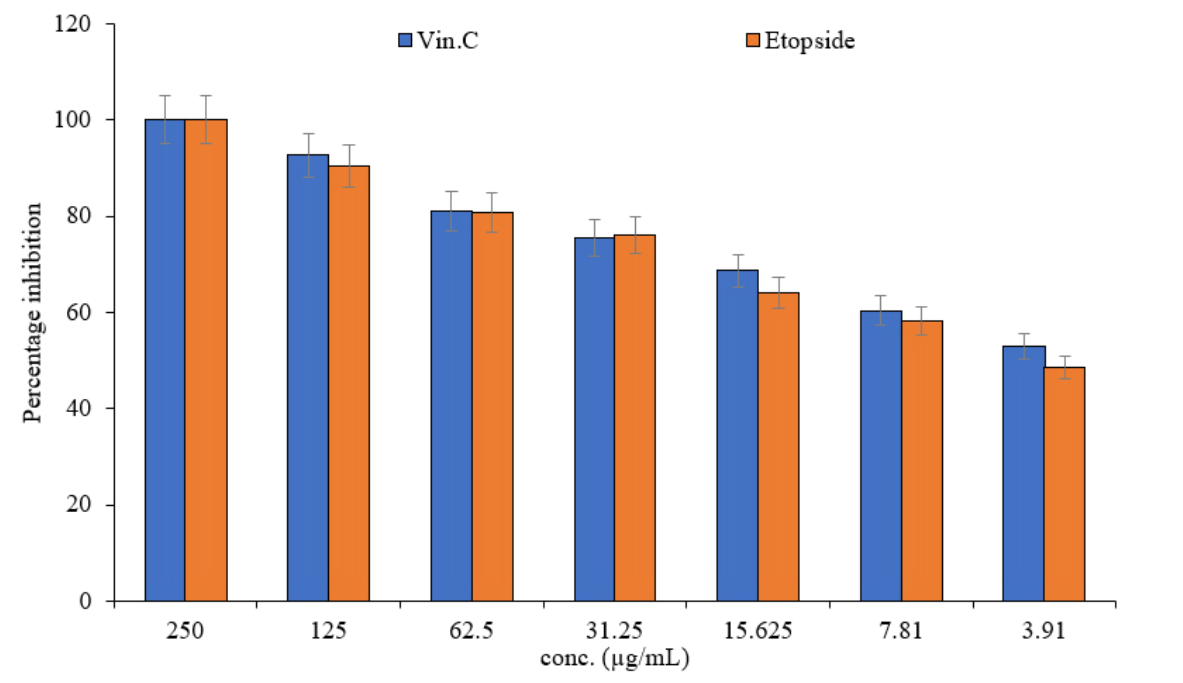
Figure 4. Percentage Inhibition of tumors by positive controls at different concentrations.